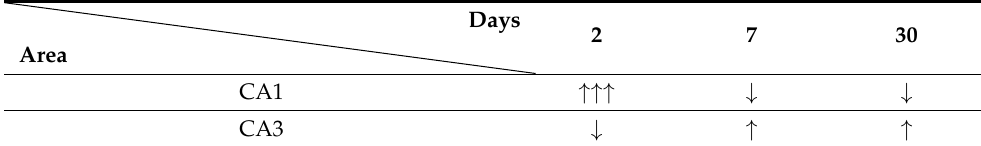
Table 1. Post-ischemic tau protein gene expression in the CA1 and CA3 area of the hippocampus on different days of